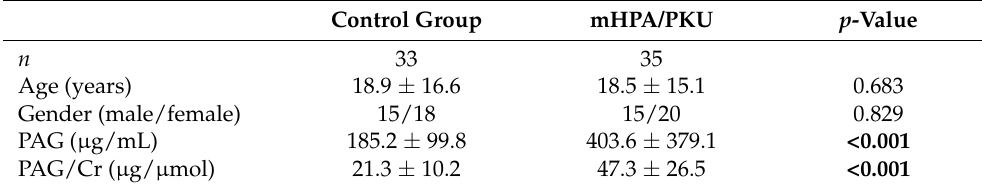
Table 1. Urine phenylacetylglutamine concentration from mHPA/PKU patients and from their healthy controls.